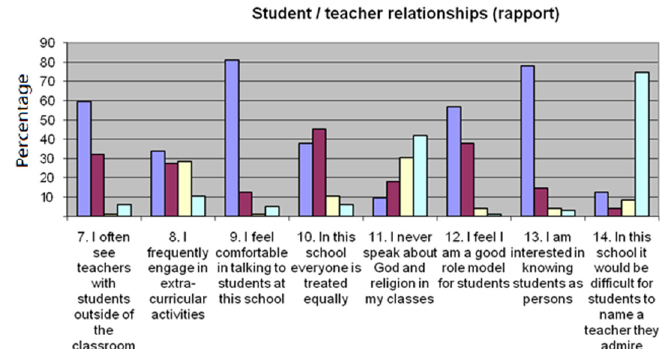
Figure 1. Student/Teacher Relationship (Rapport).